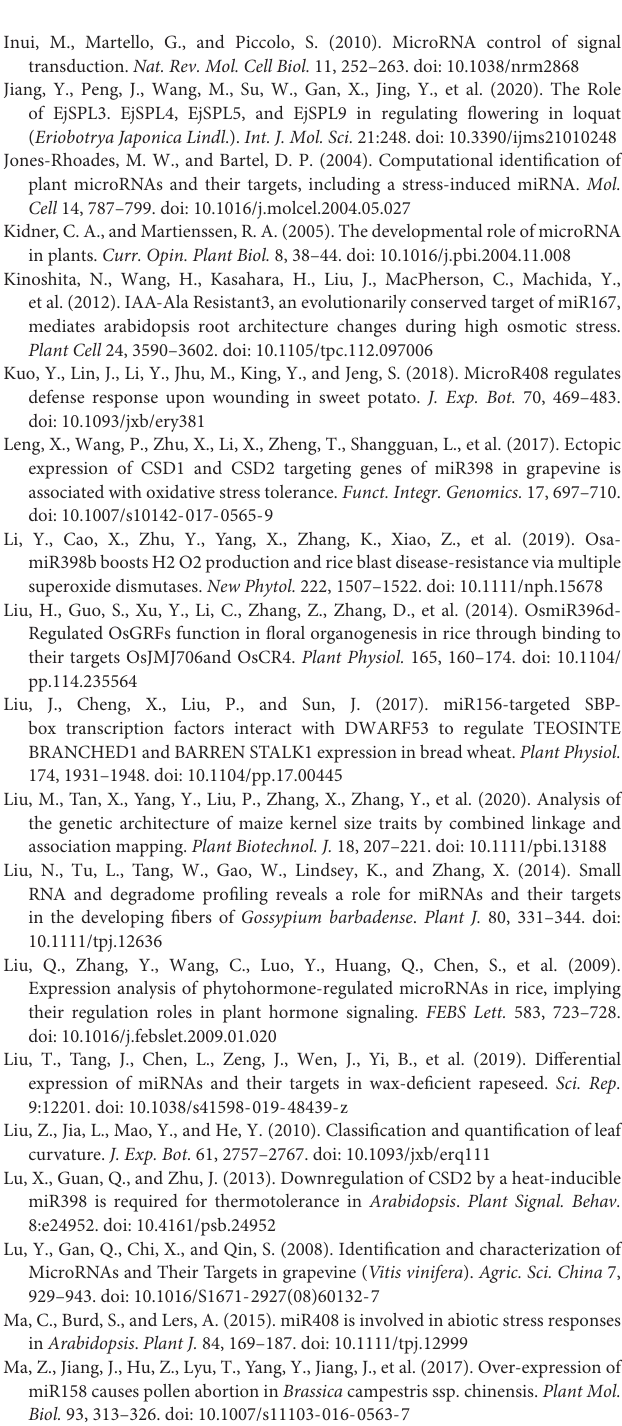
Supplementary Table 12 | Correlations among the 12 observed agronomic traits. The correlation analysis of the different traits was performed using the Supplementary Table 13 | Summary of significantly correlated